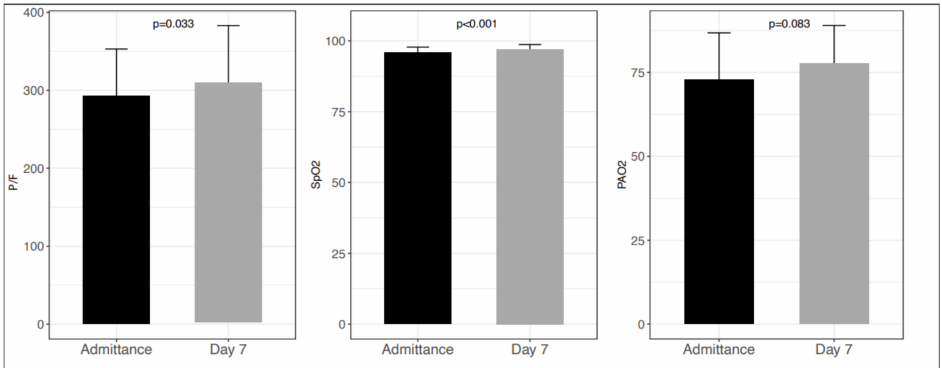
Figure 3. Lung function parameters. P/F ratio increased significantly during the first seven days of treatment, rising from 292 ± 60.4 to 310 ± 73 ( p = 0.033) as well as oxygen saturation (95.8 ± 2 at baseline vs. 97.1 ± 1.6 at day 7; p < 0.001). On the contrary, the observed increase in PAO2 did not reach statistical significance (72.8 ± 14 vs. 77.6 ± 11.4; p =